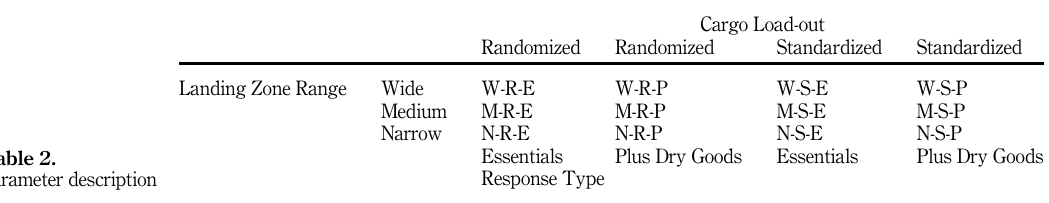
Table 1. The input model